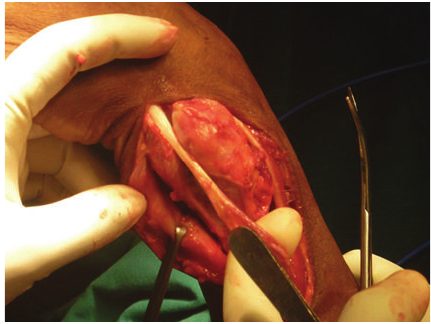
Figure 6: ECU tendon isolated.